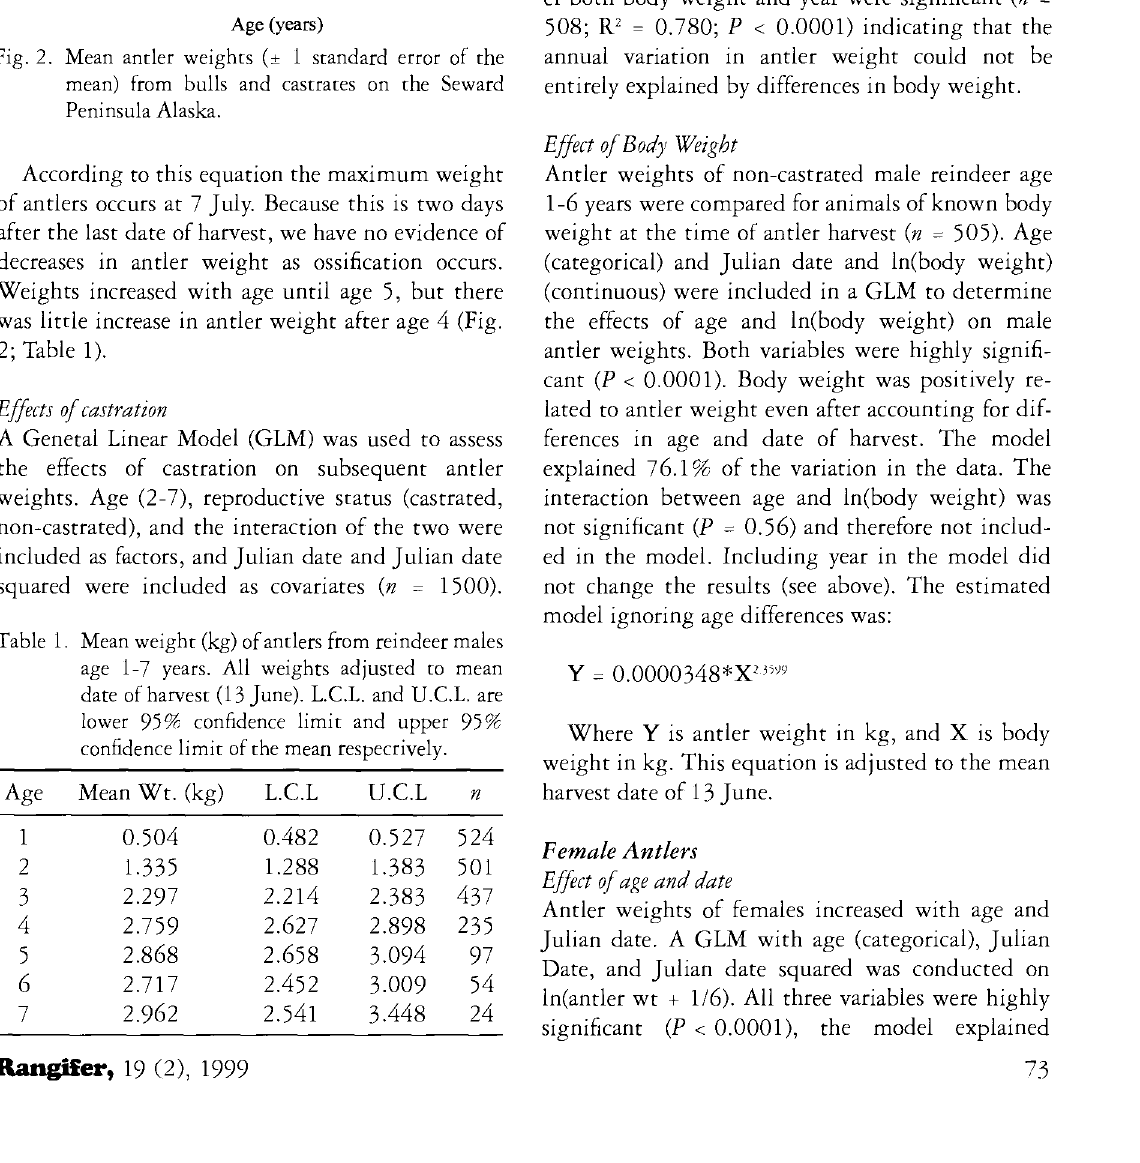
Fig. 2. Mean antler weights (+ 1 standard error of the mean) from bulls and castrates on the Seward Peninsula Alaska.